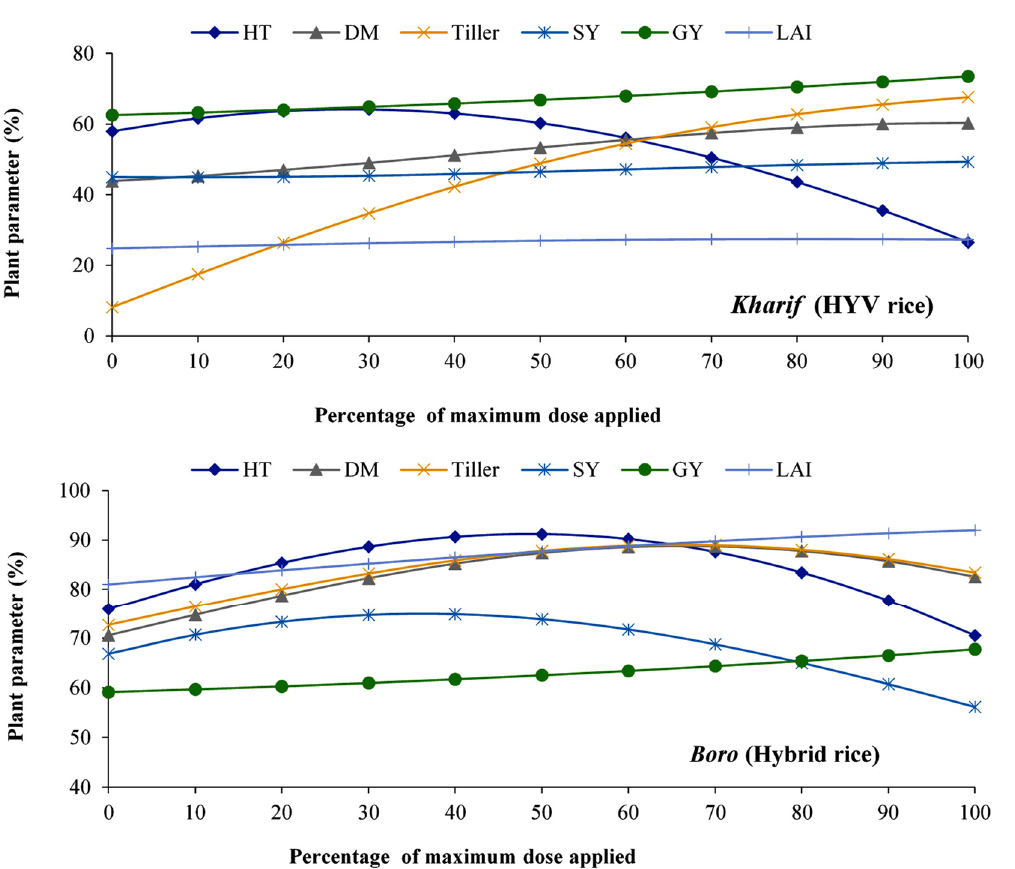
Figure 3. Effect of phosphorous on different plant parameters of kharif and boro season rice. For notation, see Figure 2.